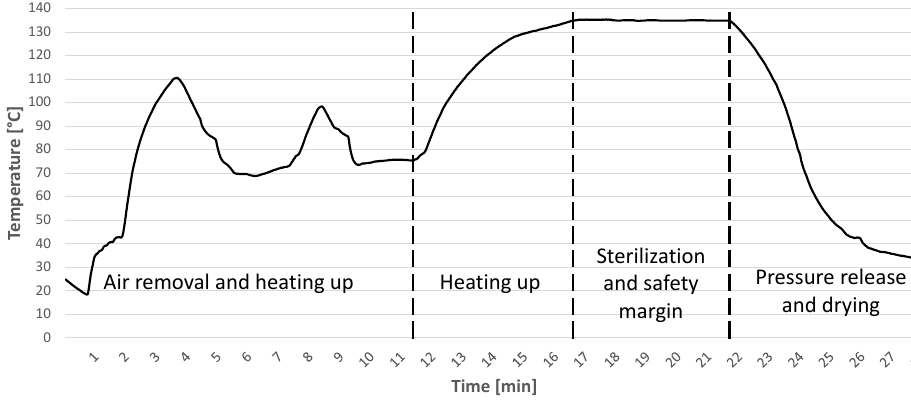
Figure 1. Temperature measurement of the standard sterilization